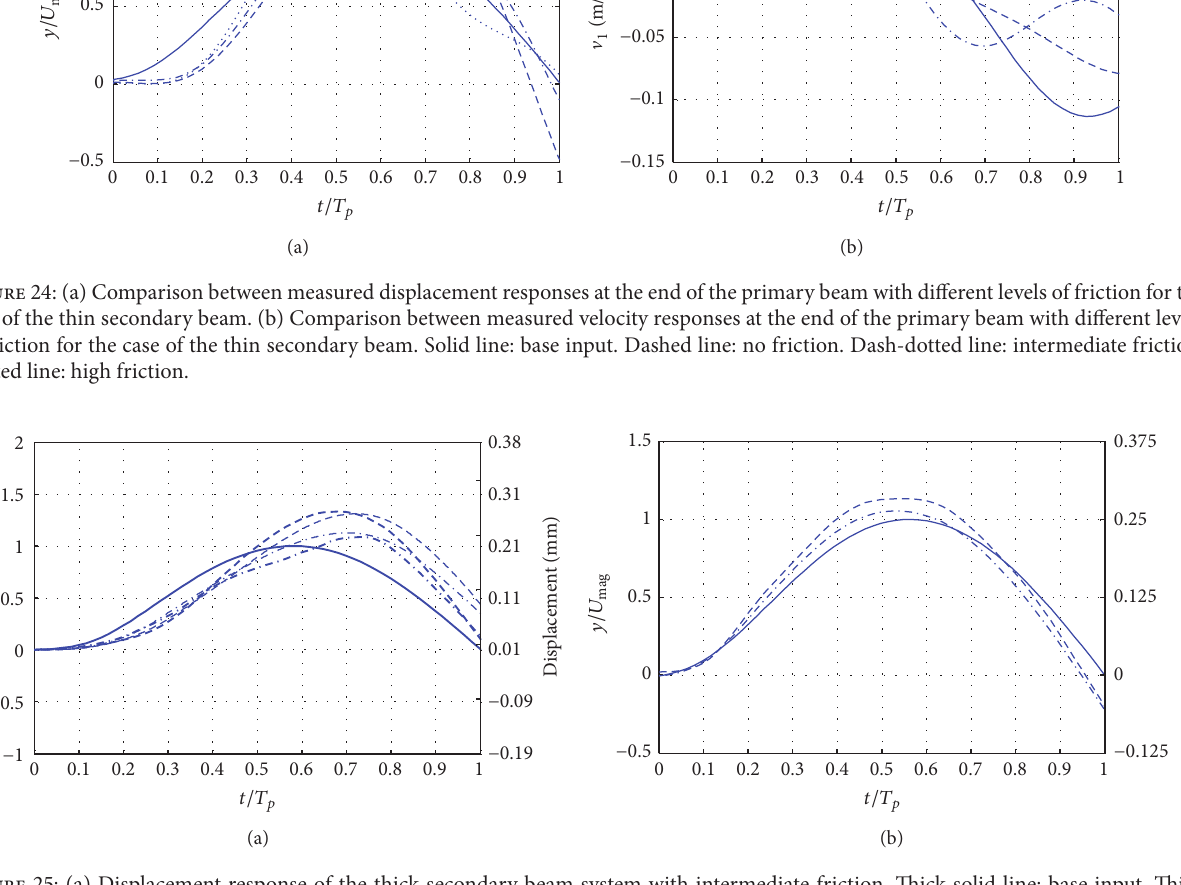
Figure 25: (a) Displacement response of the thick secondary beam system with intermediate friction. Thick solid line: base input. Thick dashed line: measured response at the end of the primary beam. Thick dash-dotted line: measured response at the end of the secondary beam. ̂𝐹 = 0.2 ̂𝐹 = 0.3 Thin dashed line: ODE simulation mass response, . Thin dash-dotted line: ODE simulation mass response, . (b) Displacement response of the thick secondary beam system with high friction. Solid line: base input. Dashed line: response at the end of the primary beam. Dash-dotted line: response at the end of the secondary